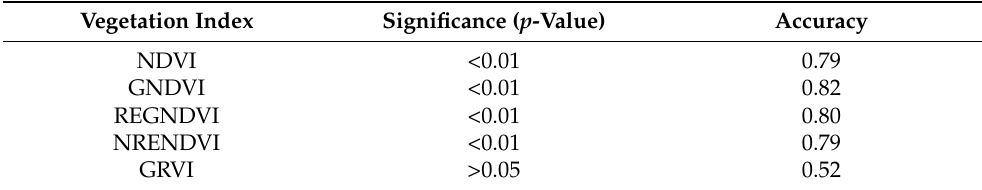
Table 5. Significant results obtained based on a t -test to determine separation between mite-infested and healthy banana plants using vegetation indices and accuracy performance based on threshold classification using vegetation